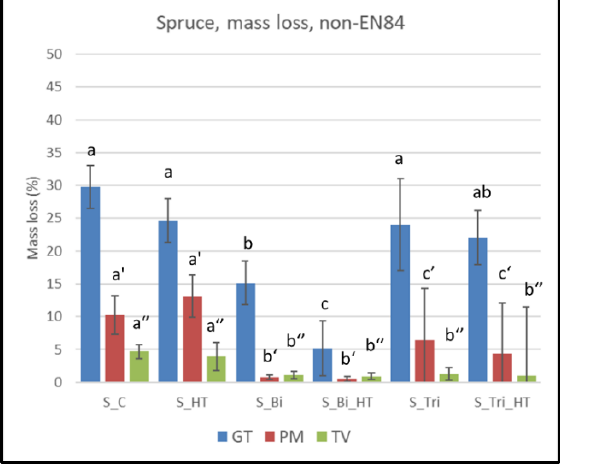
Figure 5. Mass loss of beech as a result of fungal decay, ( a ) without EN84 weathering; ( b ) with EN84 weathering. GT— G. trabeum , PM— P. monticola, TV— T. versicolor . Tukey analysis groups shown above each bar graph.